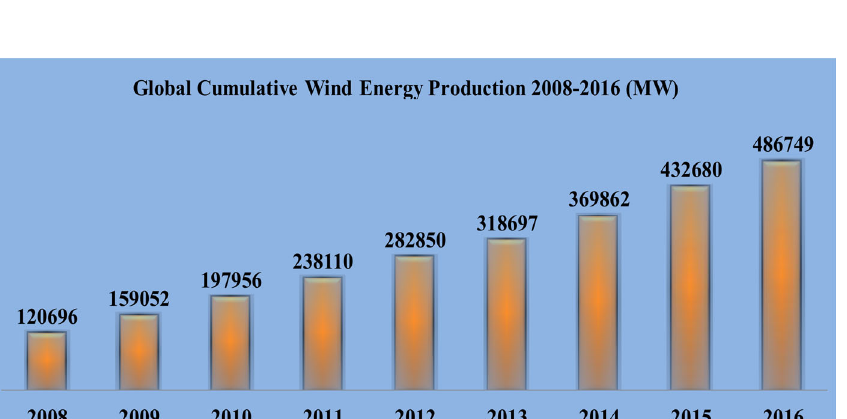
Fig. 3 Global Cumulative Wind Energy Generation in 2008-2016 [8,